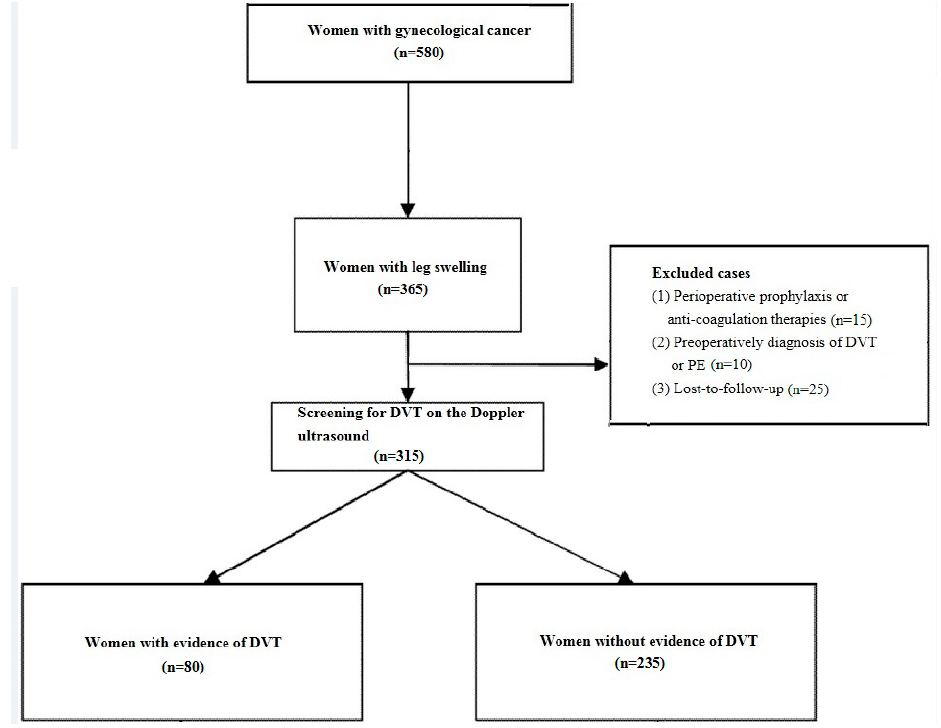
Figure 2. The study flow chart. Note: DVT, deep vein thrombosis; PE, pulmonary embolism. Table 1. Baseline characteristics of the patients.